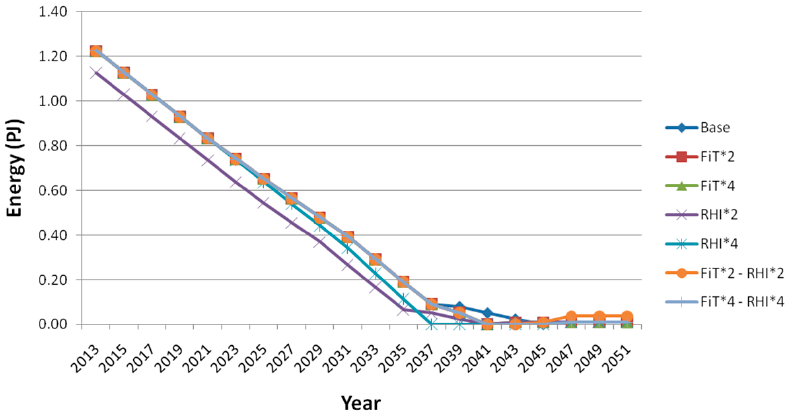
Figure 18. Specialist poultry farms—fuel consumption.